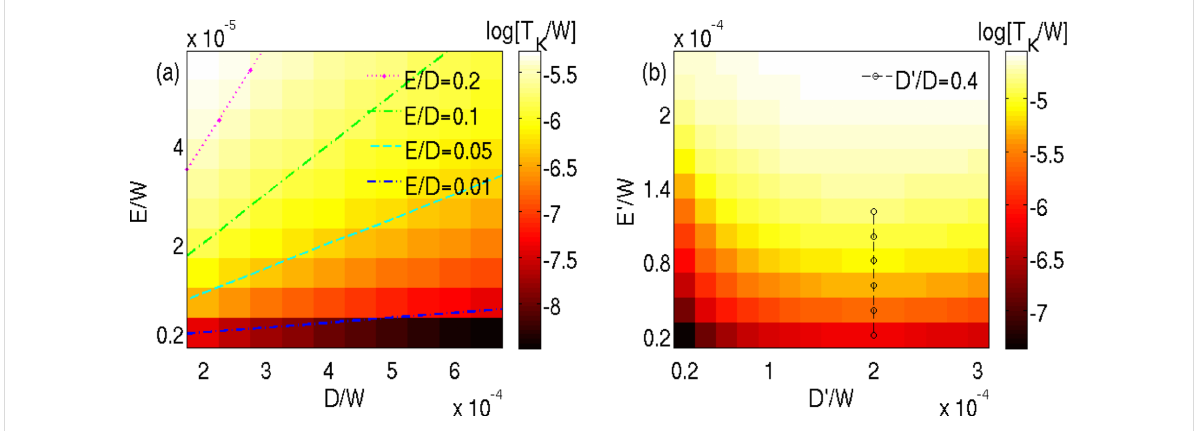
Figure 4: QST-Kondo temperature T K in units of bandwidth 2 W (log color scale) determined from the NRG level flow for S = 3/2 and J = 0.2 W . (a) Static QST-Kondo effect: T K as a function of the static anisotropy parameters D, E without spin-vibration coupling. Dashed contour lines indicate that T K increases with the ratio E / D [10]. (b) Vibration-induced QST-Kondo effect: T K as function of spin–vibration couplings D ′ and E ′ with Ω = 0.5 D for static anisotropy, D = 5 · 10 − 4 W and E = 0. The dashed line marks the regime D ′ > 0.4 D where D ′ starts to suppress T K , note the constant D here and also the offset: T K = 0 for either E ′ = 0 or D ′ = 0. Results for small finite E are similar.